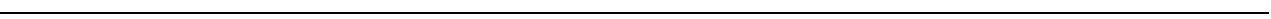
Fig. 5 Distinct Ca 2+ -dependence of small-molecular agonists of TFEB. a , b GFP-TFEB HeLa cells before and after a 30-min treatment of 200 μ M GPN (upper panel of a ) or 300 nM TG (upper panel of b ) and cells pretreated 30 min with GPN followed by a treatment with DG, AD, and IKA (lower panel). The graph represents the percentage of cells with GFP-TFEB translocation under these conditions (mean ± s.d. for n = 3 independent experiments, **** p < 0.0001 by one-way ANOVA). Scale bar, 20 μ m. c Representative images of GFP-TFEB HeLa cells treated with DG, AD, and IKA together with control siRNA (siLONRF1) treatment, siRNA-mediated inhibition of MCOLN1 (siMCOLN1) or in combination with 5 μ M FK506 (4 h) and 300 nM TG (30 min pretreatment). The graph represents the percentage of cells with GFP-TFEB translocation under these conditions (mean ± s.d. for n = 3 independent experiments, **** p < 0.0001 by two-way ANOVA). Scale bar, 20 μ m. Inset shows the immunoblot of cells treated with siLONRF1 or siMCOLN1. d Schematics of proposed mechanism of actions of DG, AD, and IKA. Cardiac glycosides, such as DG, promote binding of their molecular target (Na + -K + -ATPase) to IP3R. IP3R-dependent ER Ca 2+ release then recharges lysosomal Ca 2+ stores through an unclear mechanism, enabling lysosomal Ca 2+ release through mucolipin-1 (MCOLN1). AD targets PTPMT1 in mitochondria to perturb mitochondrial function and induce ROS release. The lysosomal Ca 2+ channel mucolipin-1 responds to elevated ROS, which results in a lysosomal Ca 2+ release. This activates calcineurin and likely additional unknown phosphatases, which de-phosphorylate TFEB and promote nuclear translocation. Furthermore, mTORC1 maintains inhibitory TFEB phosphorylation under nutrient-rich conditions. AD and IKA both increase cytosolic Ca 2+ levels resulting in CaMKK β and AMPK pathway activation, which in turn negatively regulates mTORC1 to promote TFEB activation. DG also inhibits the activity of mTORC1 through an unknown mechanism. Activation of TFEB promotes lysosomal biogenesis and autophagy and upregulates genes promoting lipid metabolism. DG-, AD-, and IKA-related proteins/pathways were coded in purple, green, and light blue. Shared proteins/pathways between DG and AD or AD and IKA were coded in cyan and dark